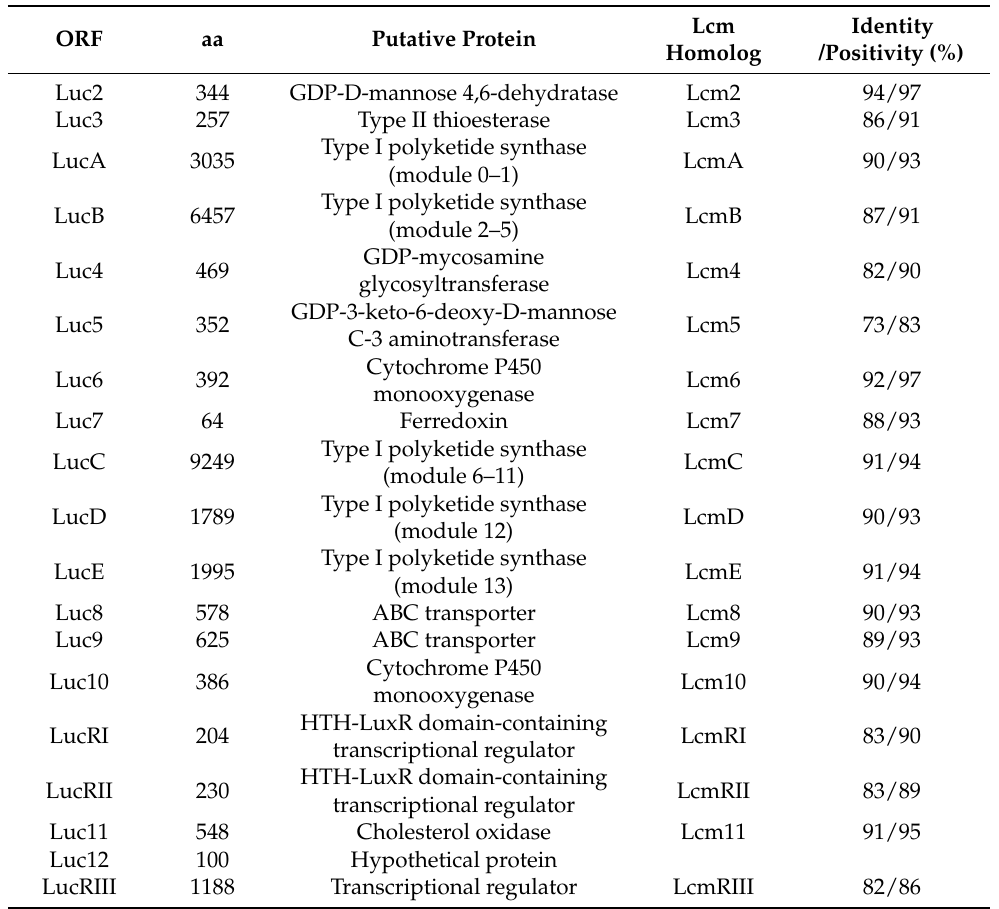
Table 1. ORFs involved in the Type I PKS cluster ( luc ) in S. achromogenes subsp. streptozoticus NBRC14001 .